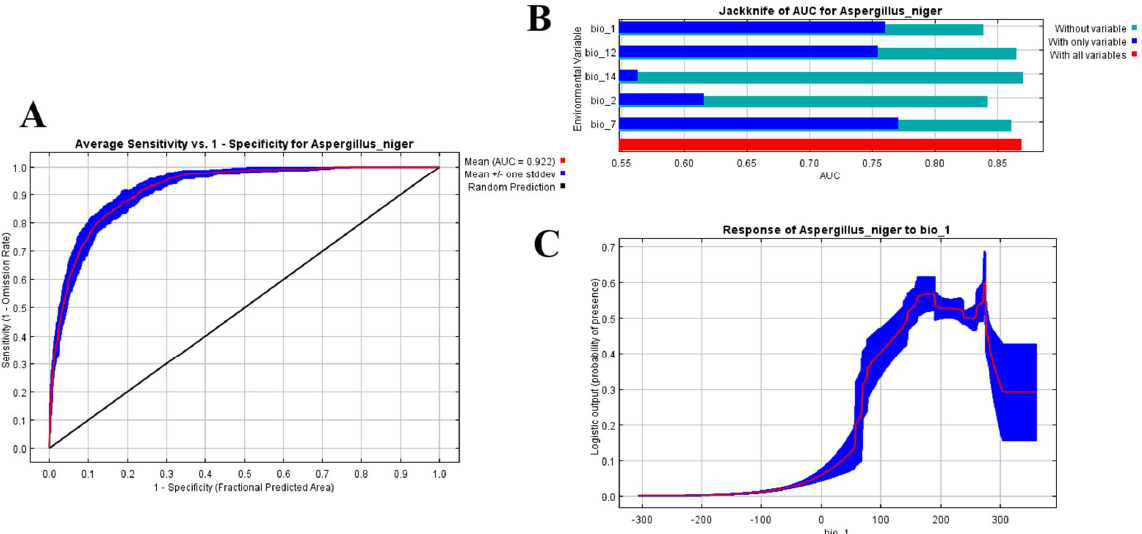
Figure 1 . ( A ). The graph of the receiver operating characteristic (ROC) curve for the black mold data, again averaged over the replicate runs. Note that the specificity is defined using predicted area, rather than true commission (AUC = 0922); ( B ). The Jackknife of the main contributed variable; ( C ). Response curve of the most effective bioclimatic factor (bio 1).